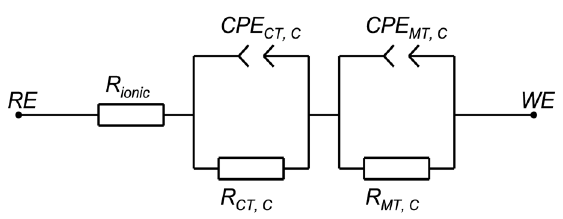
Fig. 4. Equivalent circuit of a resistor and the Voigt's structure in series with capacitors replaced by CPE ; RE and WE represent a reference electrode and a working electrode,